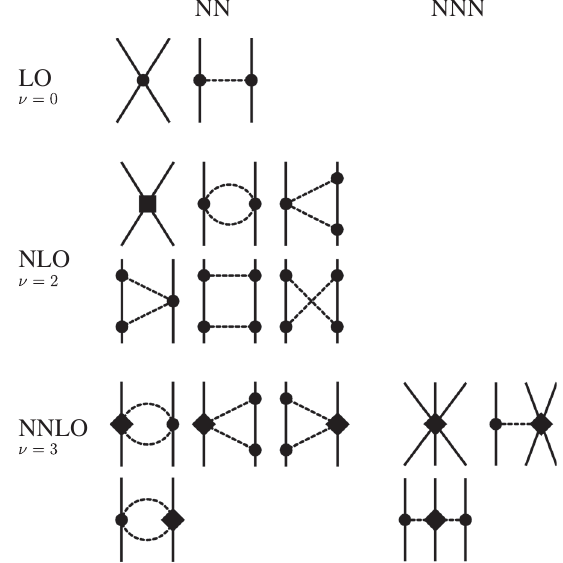
FIG. 1. Schematic overview of the Feynman diagrams present at leading order (LO), next-to-leading order (NLO), and next-to- next-to-leading order (NNLO). Nucleons (pions) are represented by solid (dashed) lines. The NNN interaction enters at NNLO. A circle, diamond, and square represent a vertex of order Δ ¼ 0 , 1, and 2,